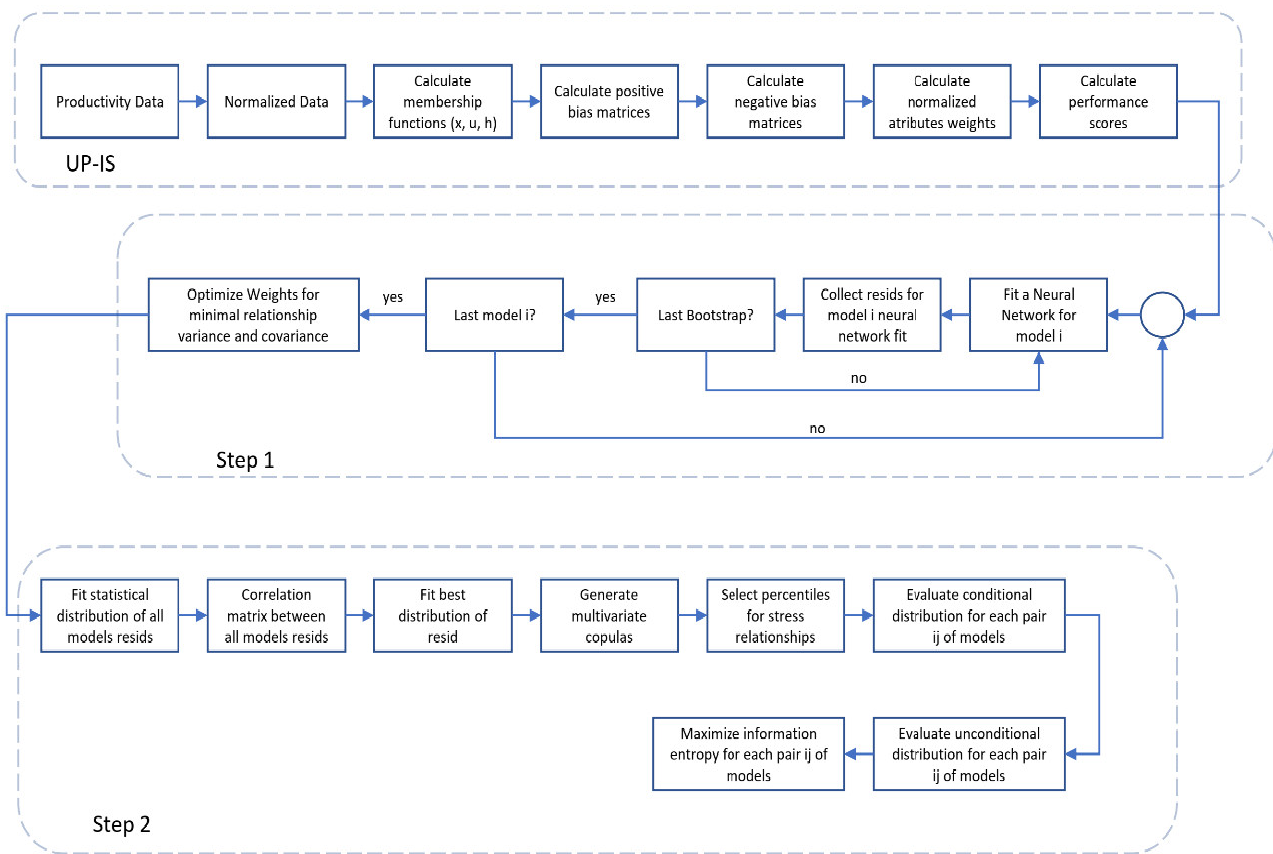
Figure 1. Flowchart of methodology.